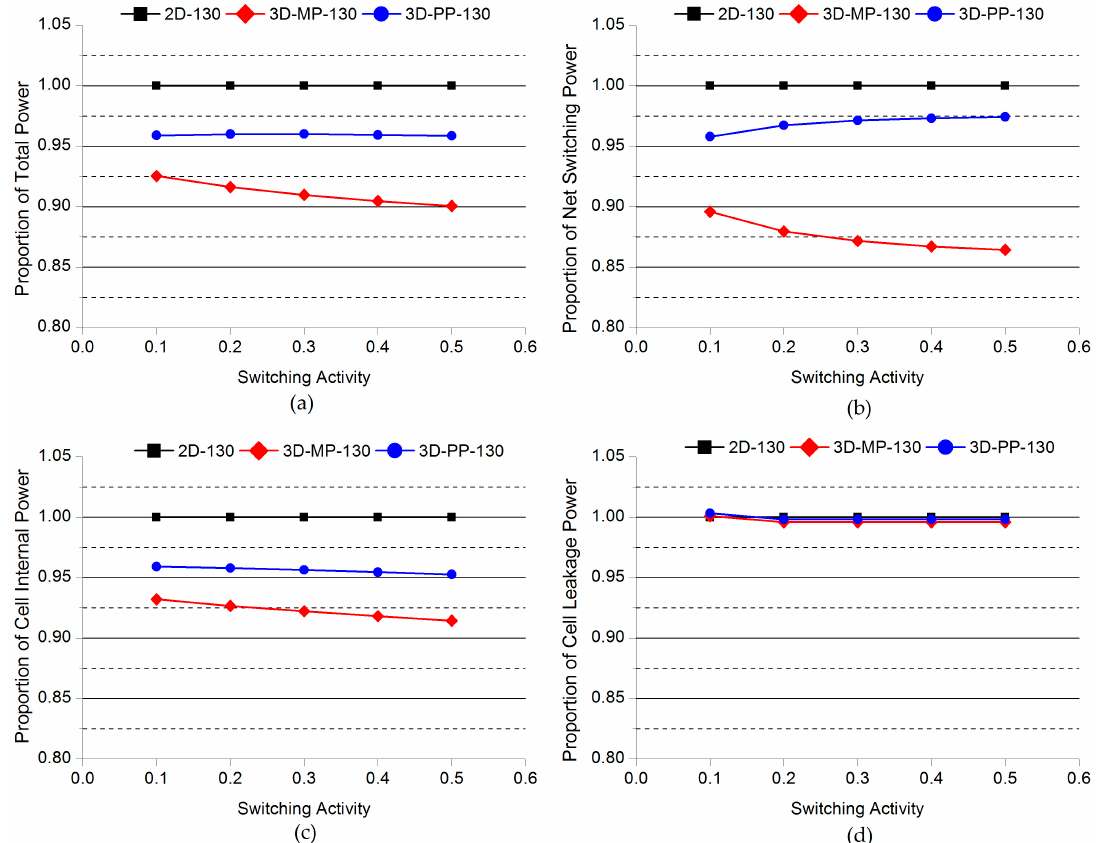
Figure 15. Comparisons of the normalized power of 2D and 3D ICs as a function of switching activity: ( a ) Total power; ( b ) net switching power; ( c ) cell internal power; ( d ) cell leakage power. Note that the power consumption of 2D-130 actually increases as the switching activity increases.